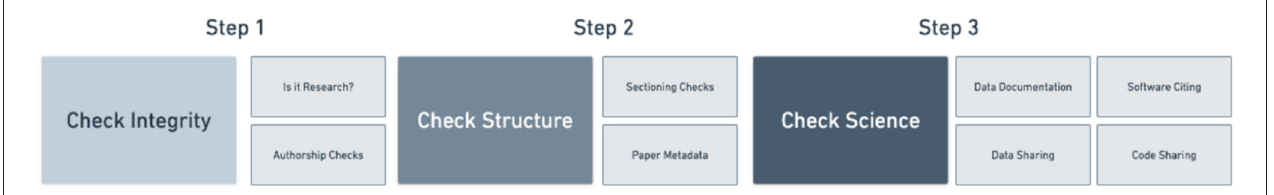
FIGURE 3 | RipetaScore scoring workflow.